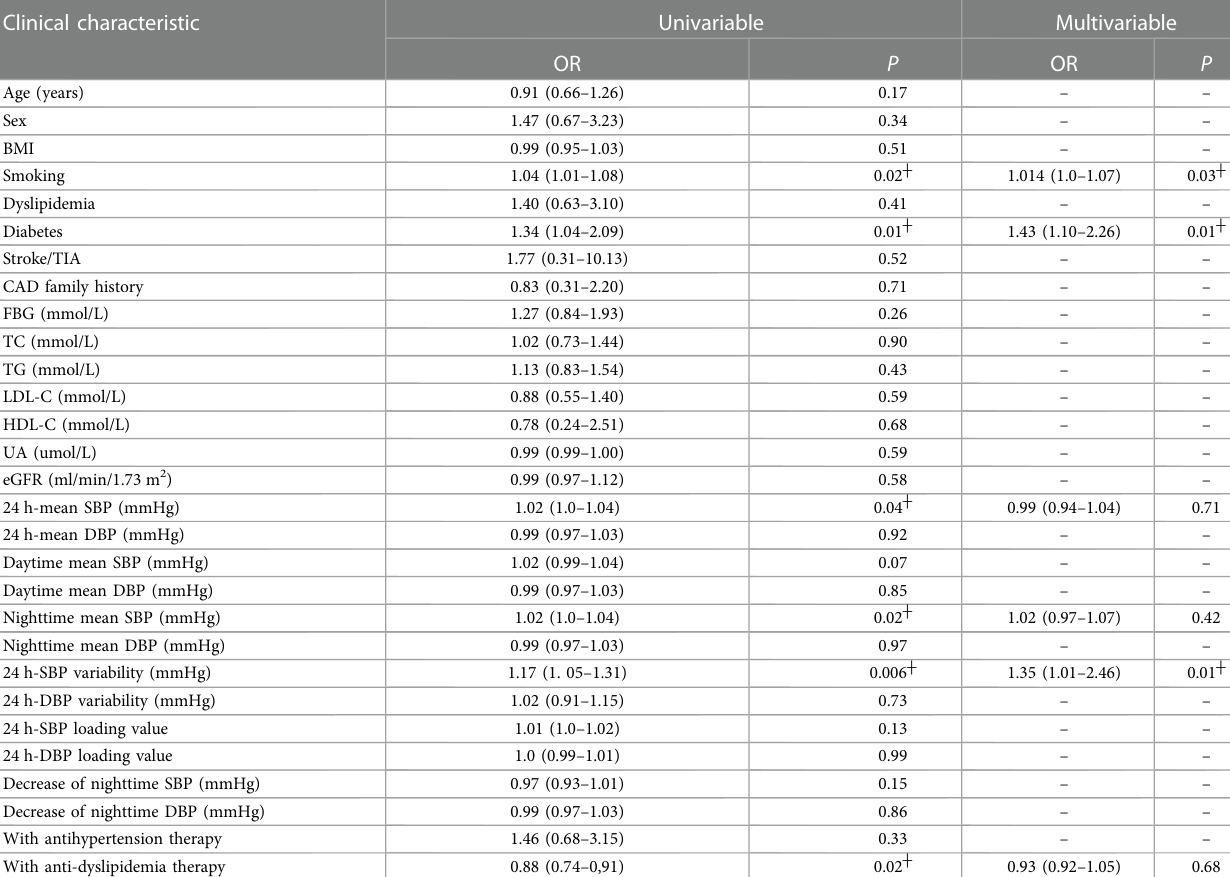
TABLE 4 Univariate and multivariate correlation analysis between clinical characteristics and Leiden score. Clinical characteristic